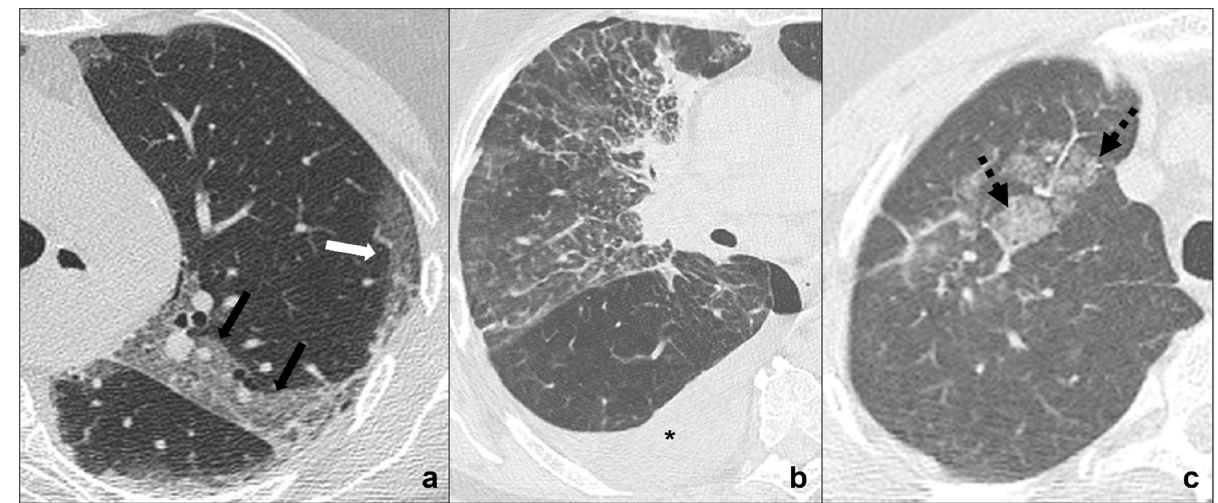
Figure 3. ( a – c ) HRTCs showing differential diagnoses of COVID-19 pneumonia stage 2/crazy-paving opacities. In stage 2, extensive, subpleural crazy-paving opacities (black arrows in a ) coexist with subpleural areas of ground-glass (white arrow in a ) and should be differentiated by lymphangitis carcinomatosis ( b ), which represents secondary spread of lung cancer to the lymphatic vessels and is frequently seen together with pleural effusion (black asterisk in b ), and by radiation pneumonitis (acute radiation-induced lung disease) presenting with crazy-paving pattern (dotted black arrows in c ) in the field of radiation. Lungs: mean window with 1500 HU; mean window level − 600. Mediastinum: mean window with 350 HU; mean window level 50 HU.